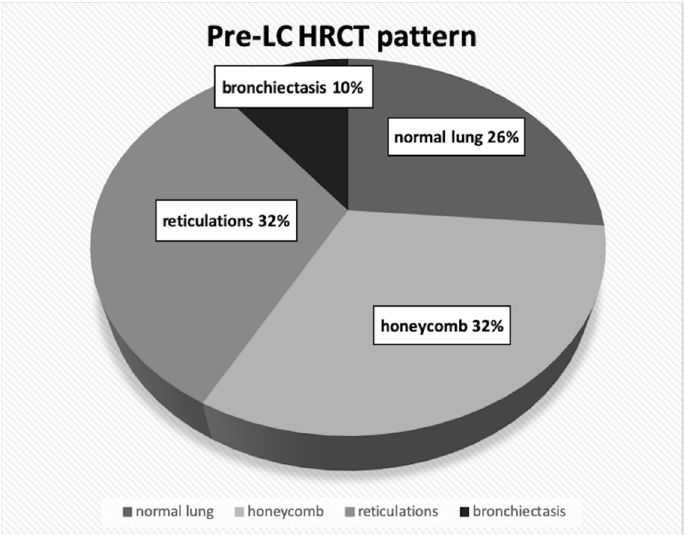
Figure 1. Prevalence of different HRCT patterns identified in our idiopathic pulmonary fibrosis (IPF) patients having lung cancer.